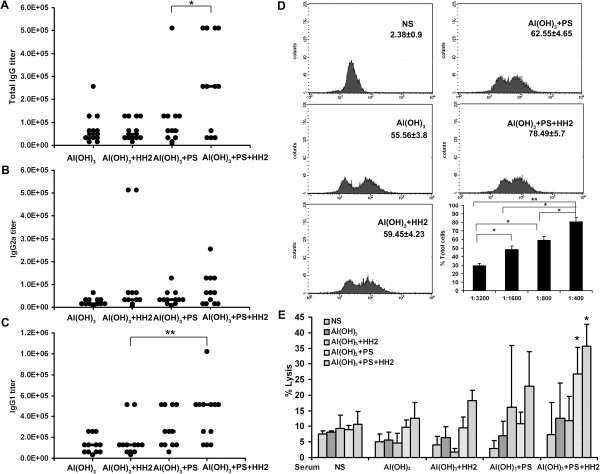
NAPH increases NY-ESO-1-specific antibody immune response. A, The titers of anti-NY-ESO-1 total IgG were measured using ELISA. Dot, titer of each mouse. B, C, The titers of anti-NY-ESO-1 IgG2a/IgG1 titers in the treated groups were measured. D, FACS analysis using NY-ESO-1-B16 cells to detect NY-ESO-1-specific IgG antibodies (n = 3 mice, pooled composite results are shown). E, Antibody-dependent cellular cytotoxicity was determined using the 51Cr-release assay. NY-ESO-1-B16 cells were labeled with 51Cr and coated with sera from control or treated mice. Splenocytes from untreated or treated mice were used as effectors. The assay was run in three replicates.